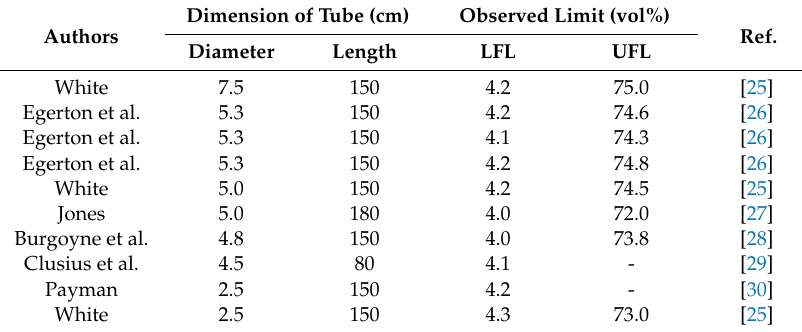
Table 1. Measured flammability limits of hydrogen in air at normal temperature and pressure. Reproduced from Ref. [14], US Government Printing O ffi ce: